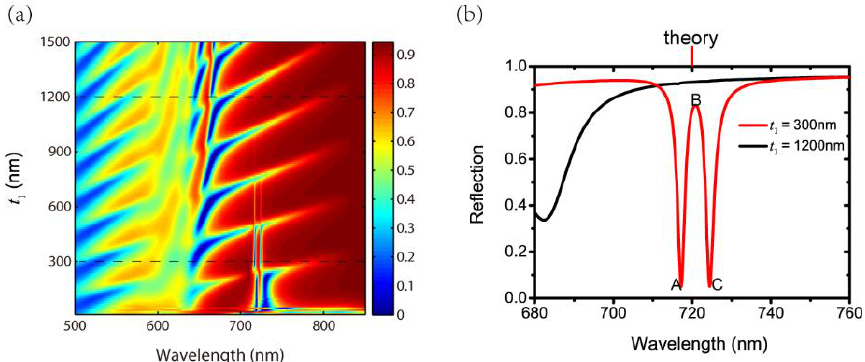
t ; ( b ) Reflections with 1